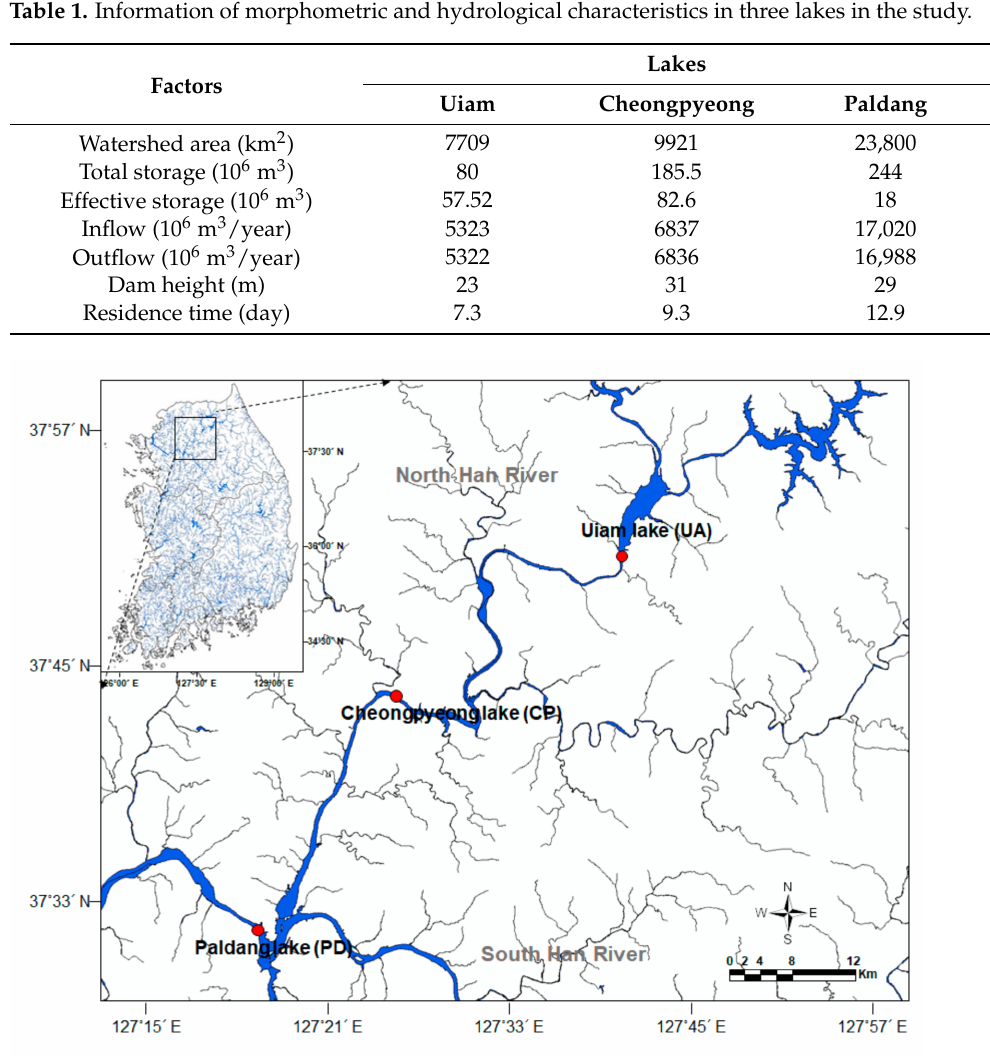
Figure 1. Locations of the study sites ( • ) in the Han River watershed of South Korea. Phytoplankton and environmental variables were surveyed according to the sampling protocol of HRWMC [12]. Water samples at each layer for the identification of phyto- plankton species and measurement of cell densities were taken using a Van Dorn sampler (Halltech Environmental Inc., Guelph, ON, Canada) and stored in Whirl-Pak bags (250